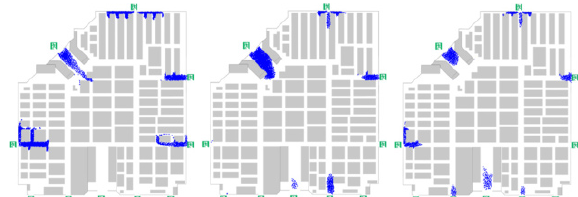
Fig. 9 Exhibition. Snapshots of unevacuated agents for each method at frame 2800. Left to right: the shortest path algorithm (4122 remaining), the weighted graph algorithm (2549 remaining), and our method (1559 remaining). The lower exits were not utilized well by the shortest path algorithm.